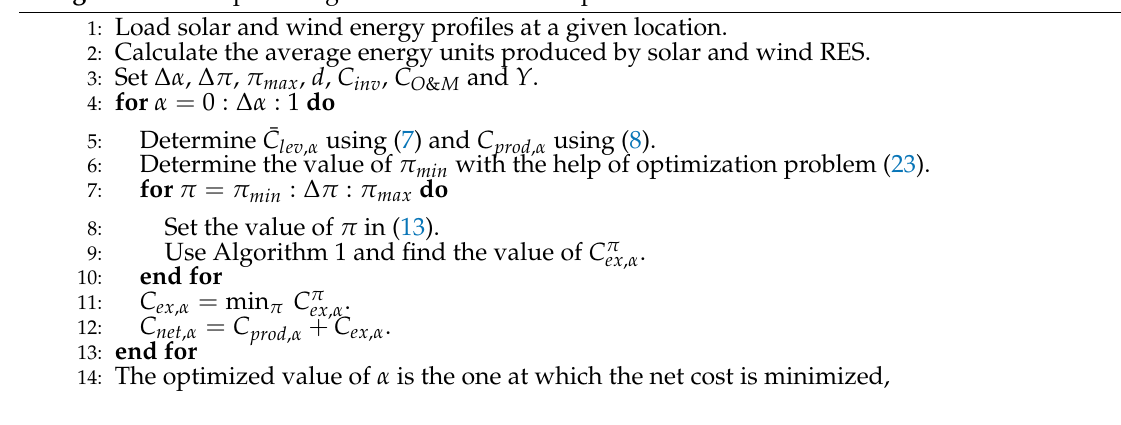
Algorithm 2: Proposed algorithm to determine optimized RES mix.